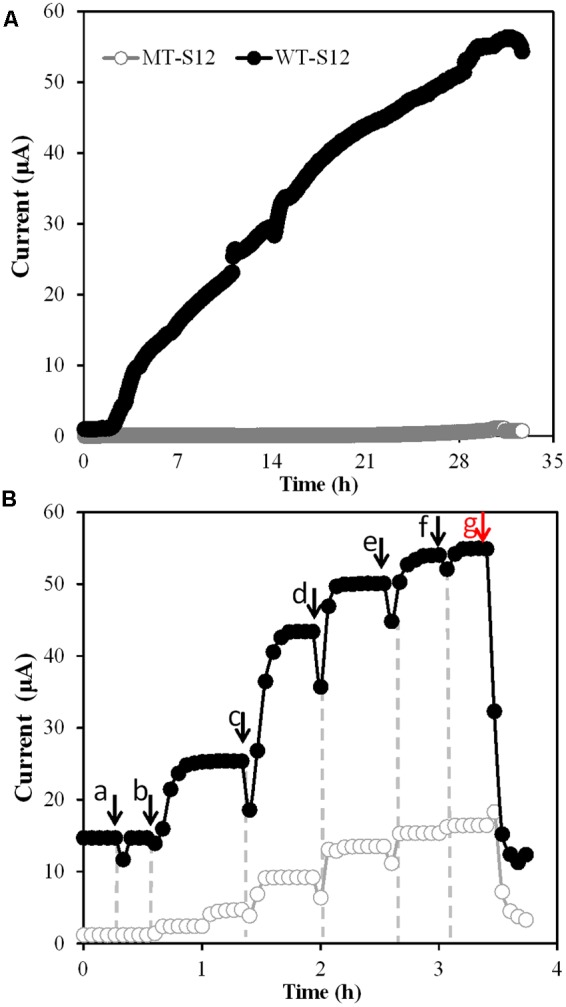
(A) Electricity generation by MT- and WT-S12 under normal condition. (B) Electricity generation by MT- and WT-S12 with increased riboflavin concentration, arrow a indicates addition of flavin-free PBS, arrow b to f indicates addition of 2 μm flavins for each, red arrow g indicates protease K treatment.